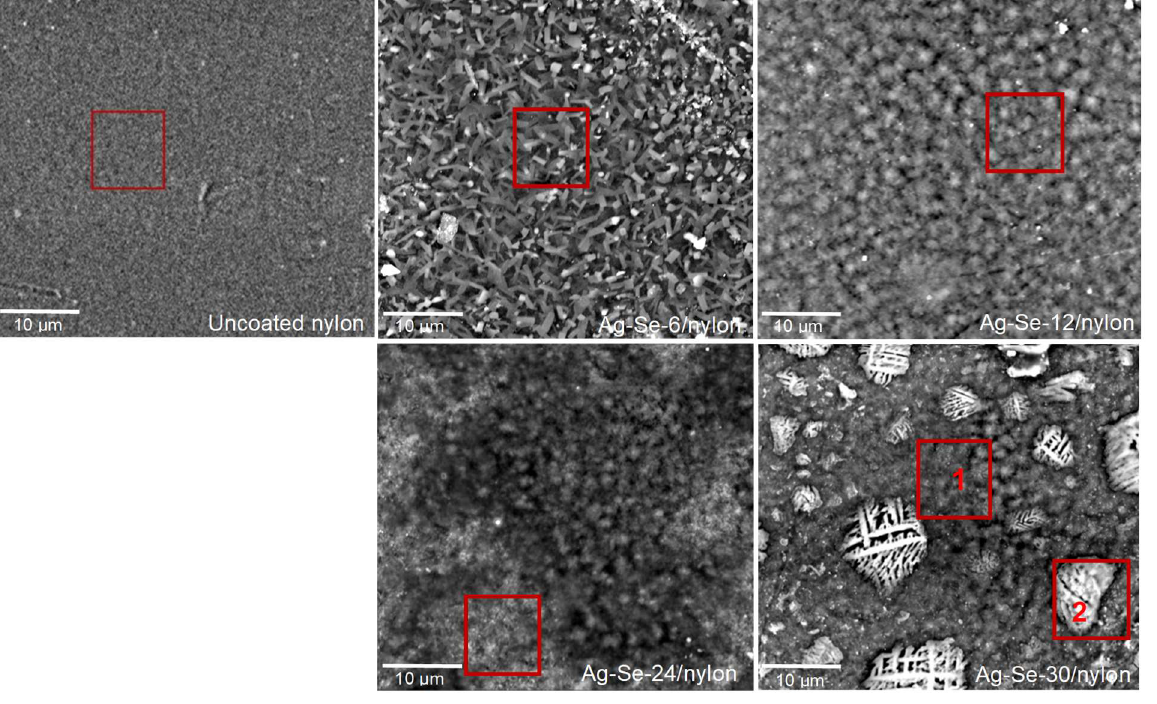
Figure 2. SEM microphotographs of uncoated nylon and Ag–Se/nylon samples with the marked area where the elemental composition was determined by Phenom area where the elemental composition was determined by Phenom ProX-SEM-EDS.